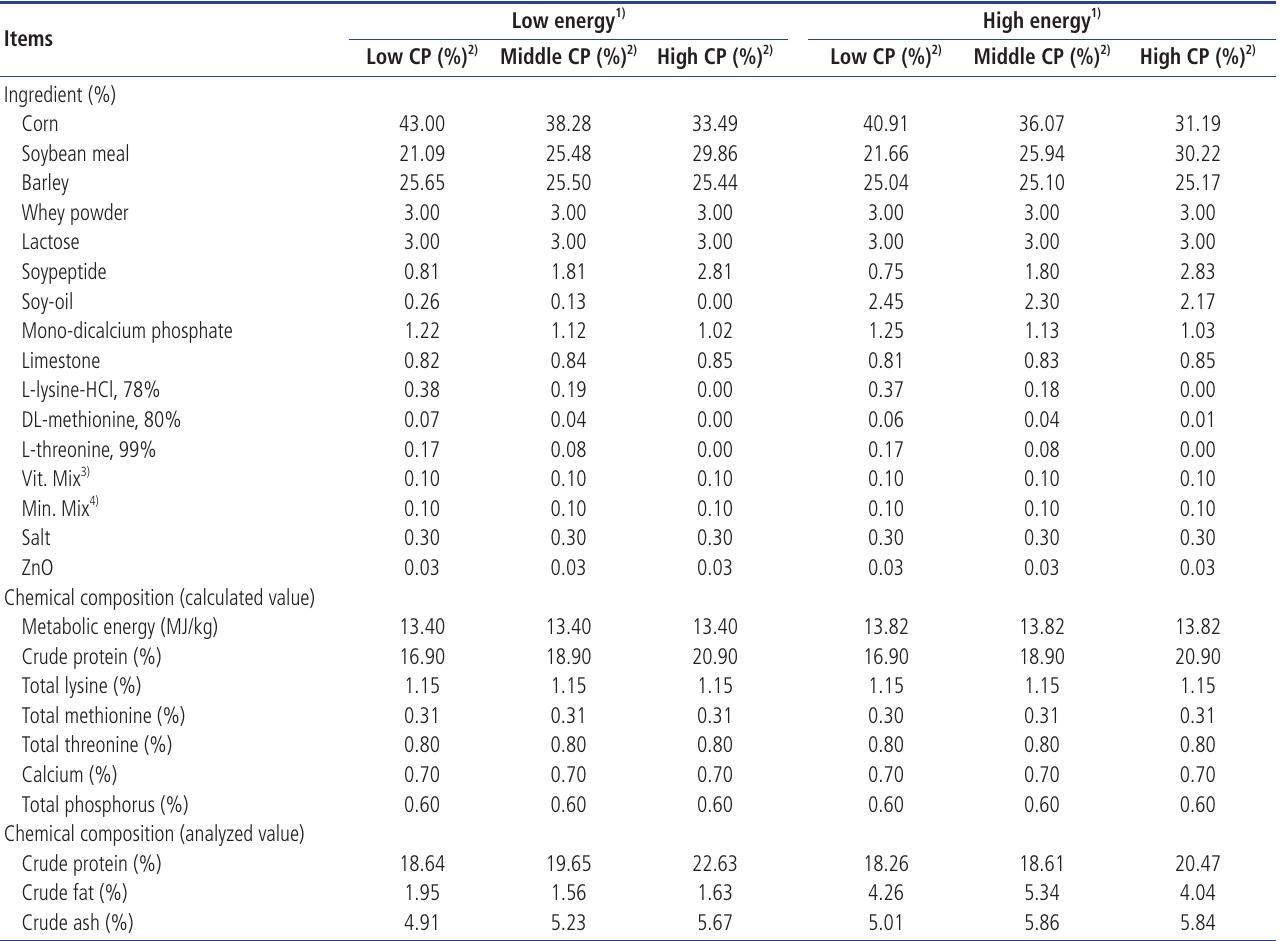
Table 2. Formulae and chemical compositions of diets in late weaning pigs Items